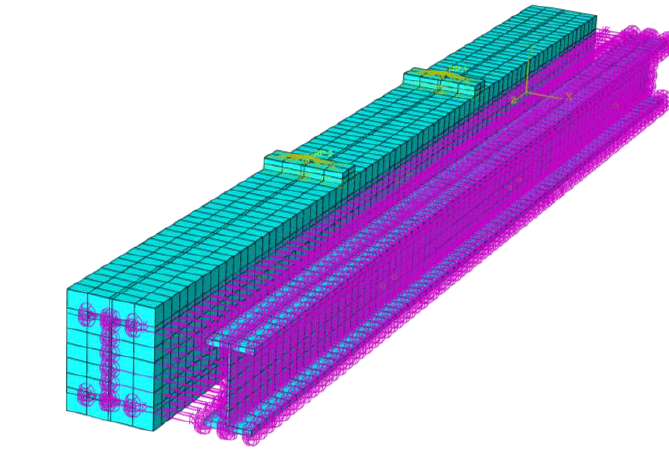
Figure 7. Finite element model of SRC beam.